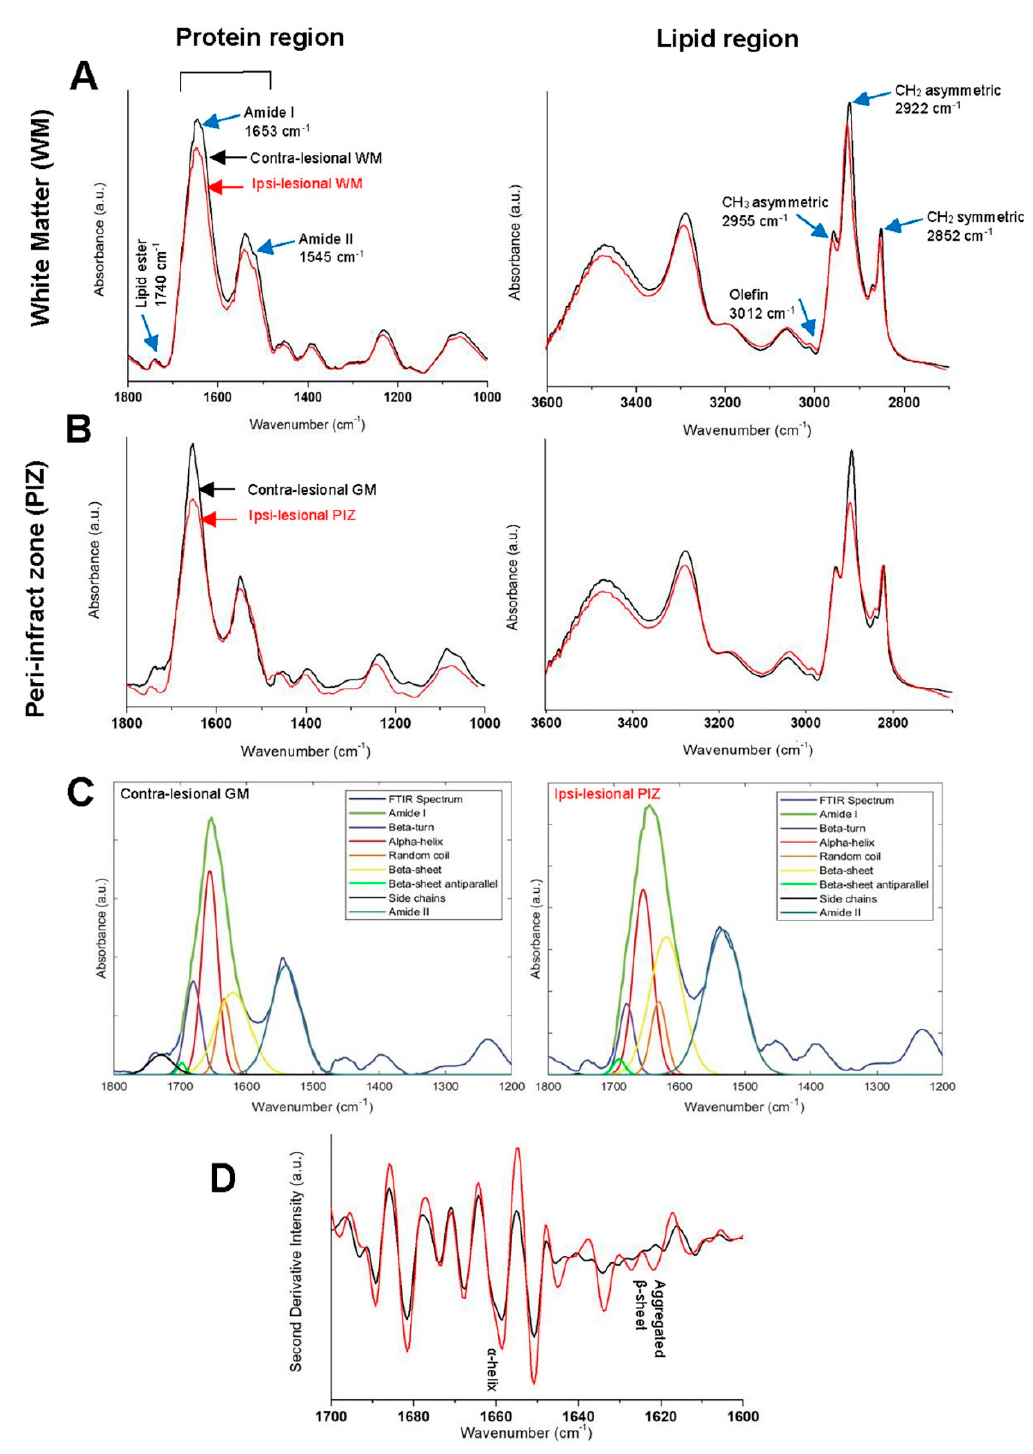
Figure 4. Comparison of Fourier Transform Infrared (FTIR) spectra from ( A ) White matter—WM and ( B ) Peri-infract zone—PIZ at contra-lesional (black) and ipsi-lesional (red) hemisphere of nine weeks post stroke showing the changes of peaks in Protein and Lipid regions separately. ( C ) Representative curve fitting spectra from– contra-lesional gray matter (GM) (left) and ipsi-lesional PIZ (right) quantifying changesinrelativeamountofaggregatedproteinfrom α -helixand β -sheetvariations. ( D )Representative second derivative spectra from PIZ showing α -helix and β -sheet variations. The peak assignments (name + wavenumbers) are specified by blue